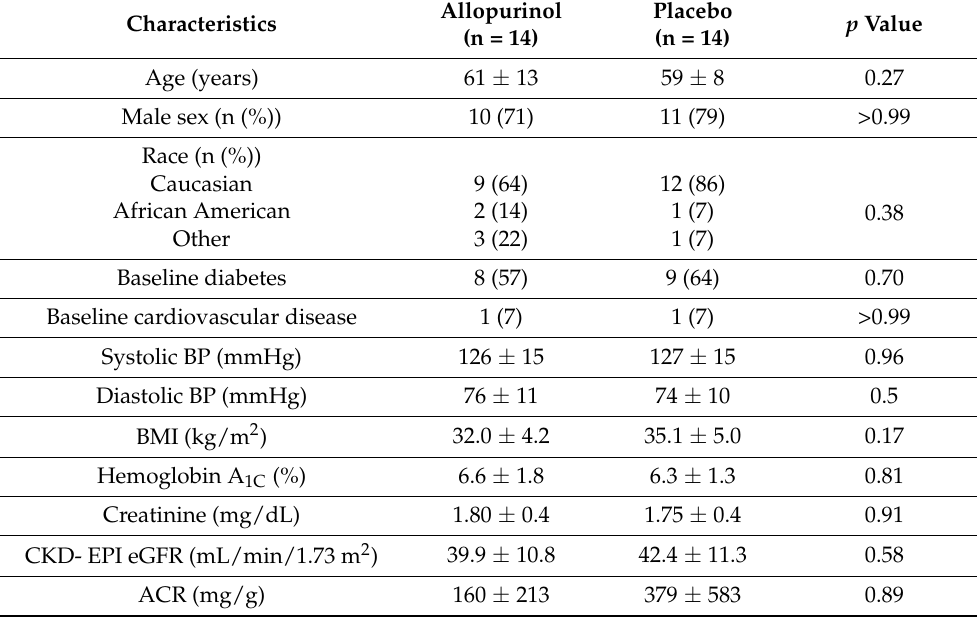
Table 1. Subjects Baseline